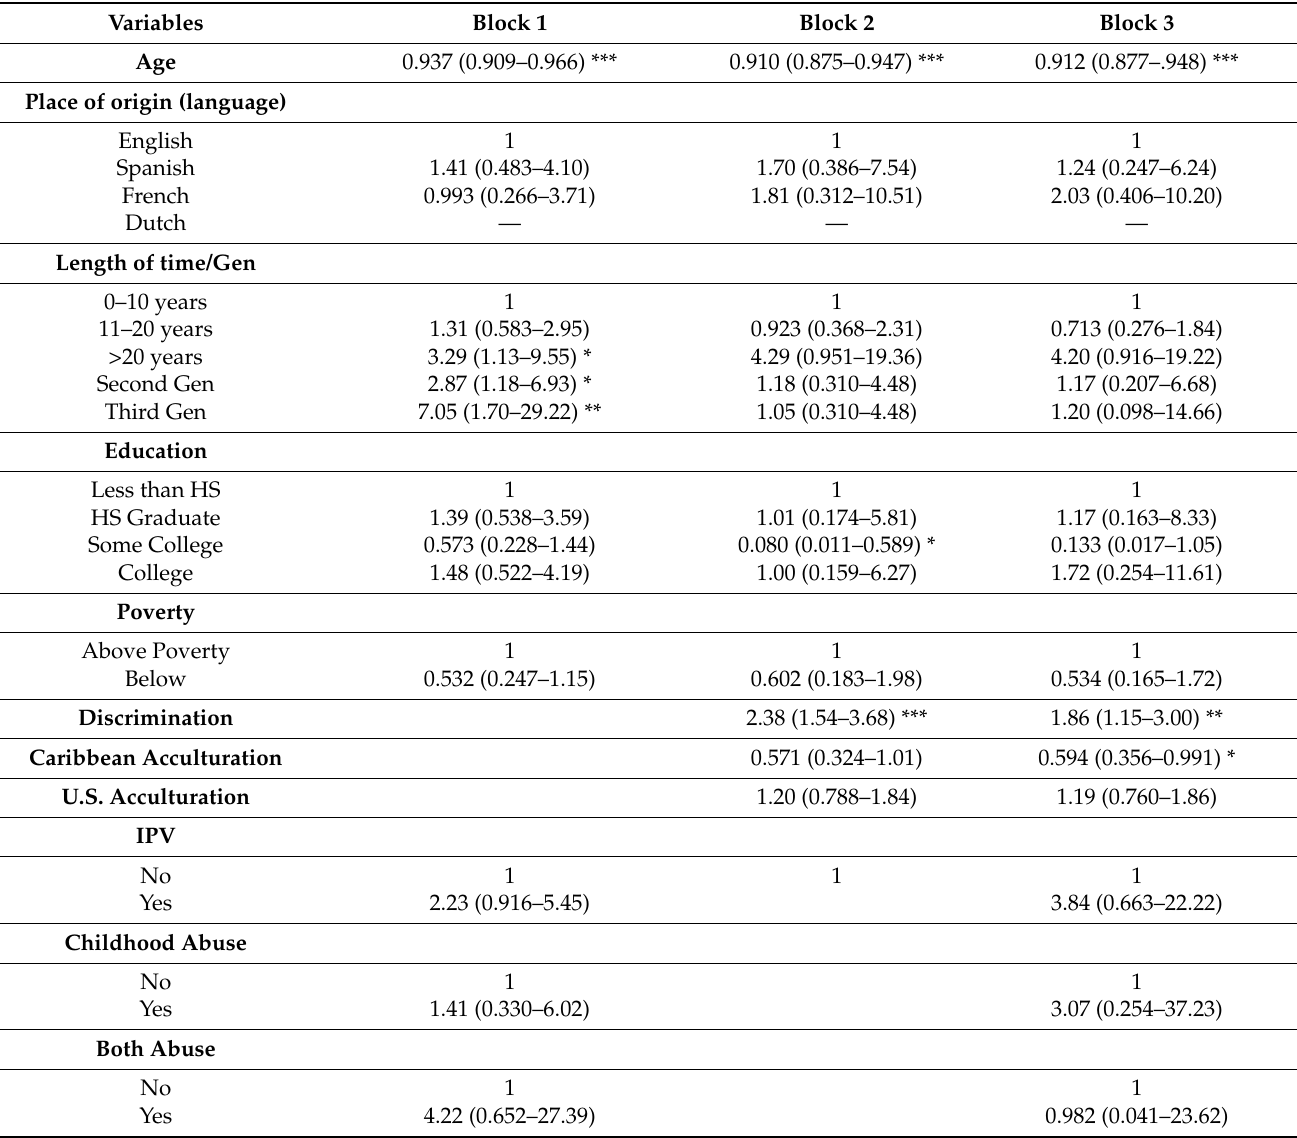
Table 5. Multivariate Analysis Examining Domestic Violence, Acculturation, Discrimination and Demographic Factors on Lifetime Suicide